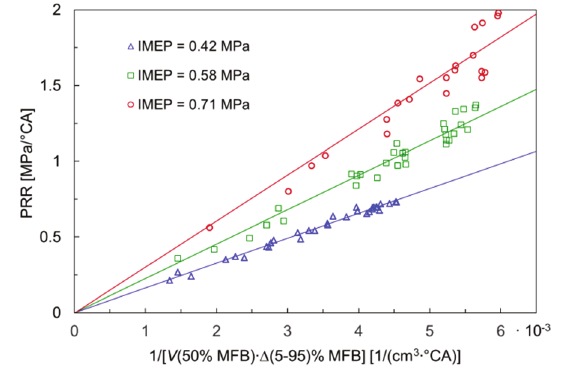
Fig. 6. Pressure rise rates as a function of the inverse of combustion dura- tion and volume at 50% MFB for all investigated conditions